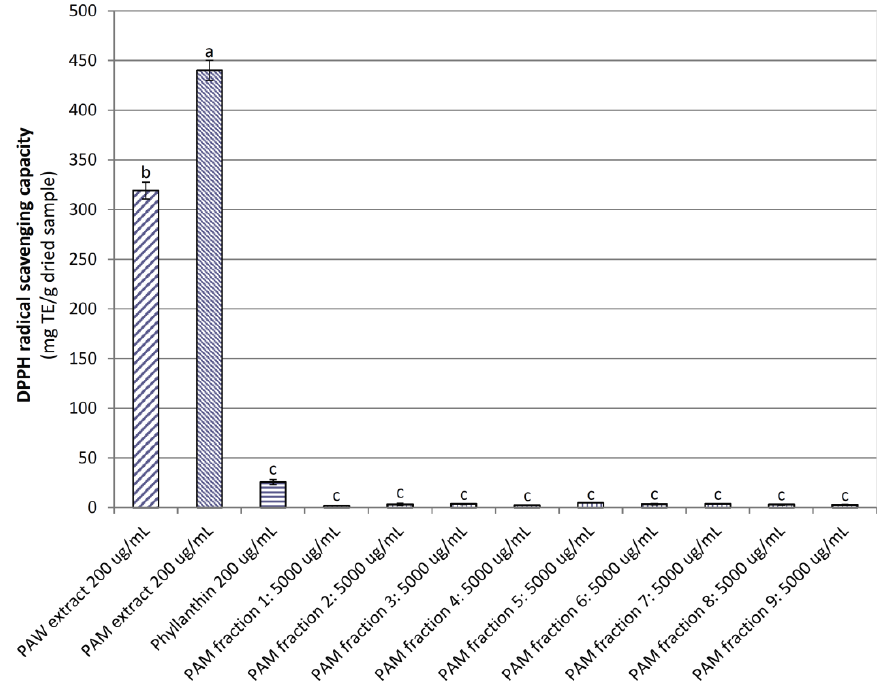
Figure 3. The DPPH radical scavenging capacity of powdered P. amarus water ( PA W) and methanol ( PA M) extracts and PA M fractions. Phyllanthin was used as a positive control. Different letters within the columns denotes a significant difference between treatments ( p < 0.05). Medicines 2017 , 4 , 42